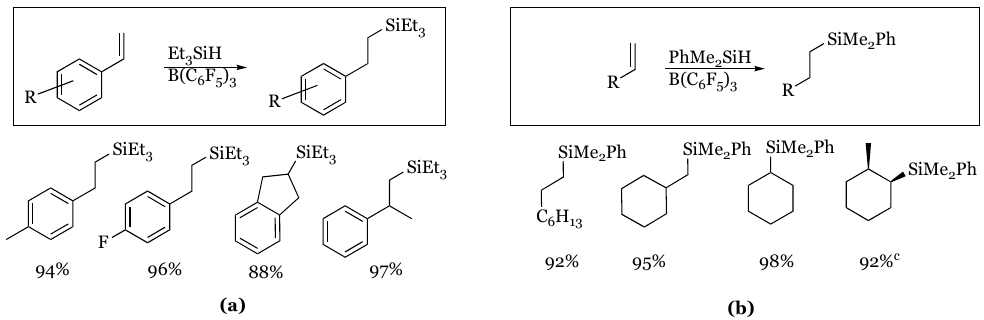
Figure 5. Hydrosilylation of olefins: ( a ) styrene derivatives with Et 3 SiH; ( b ) aliphatic systems with PhMe 2 SiH. c Product ratio cis: trans = 96:4.